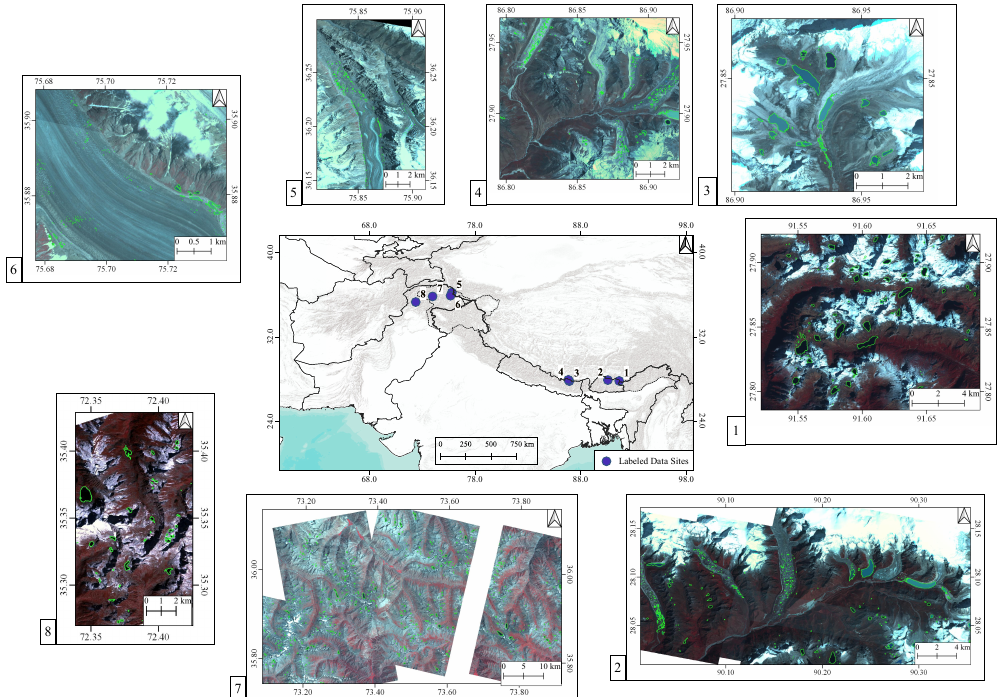
Figure 2. The locations of the images used for creating the datasets overlaid on ESRI Terrain basemap. Digitized polygons in each location are shown on the respective PlanetScope False Color